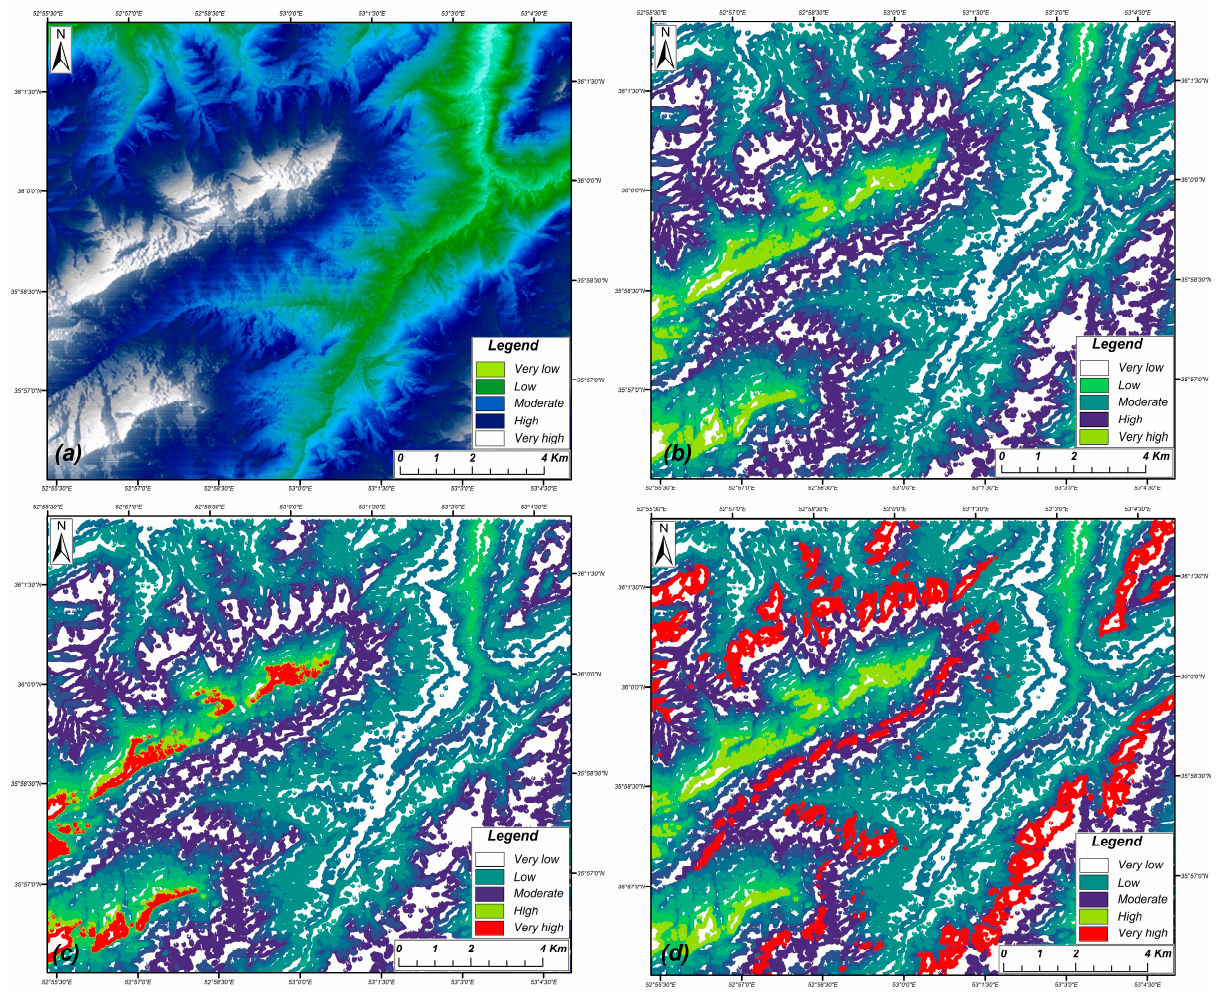
Figure 9. Pixel grid cells intensity evaluations during processing of images.